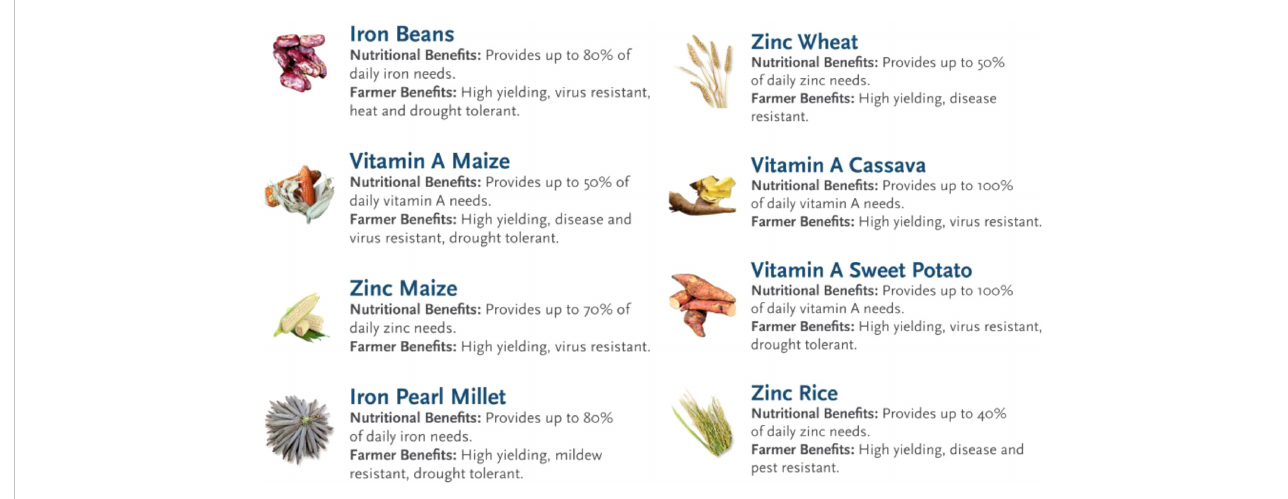
FIGURE 4 Detail of the nutrient-rich crops and their bioavailability potential and key farmer-preferred traits (source: CGIAR